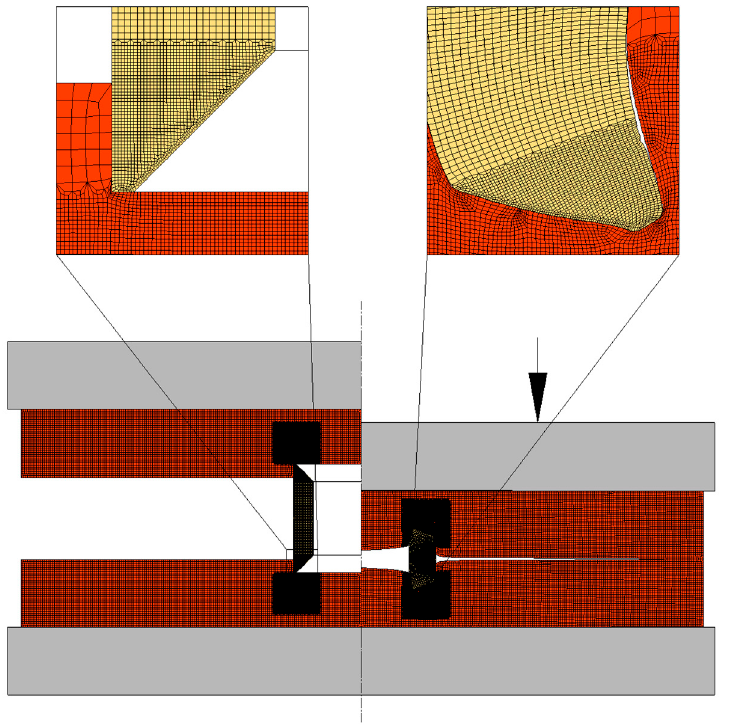
Figure 4. Finite element model at the start and end of the DSSPR joining process of two sheets having flat-bottom holes with a depth 𝑑 (cid:3043) of 1 mm.